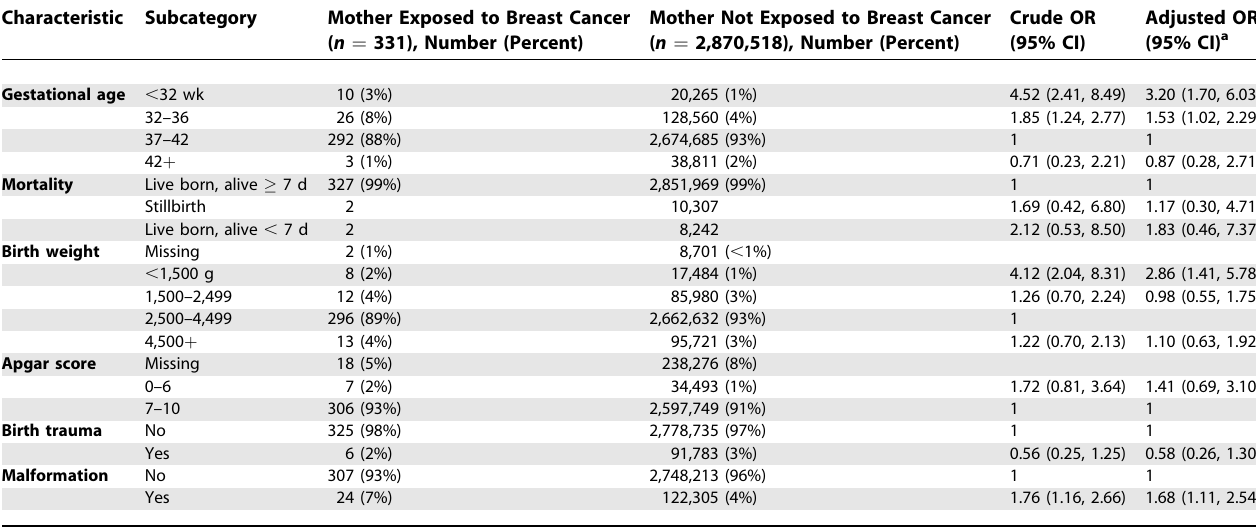
Table 3. Characteristics of Infants Born to Women Previously Treated for Breast Cancer Compared with the General Population of Infants